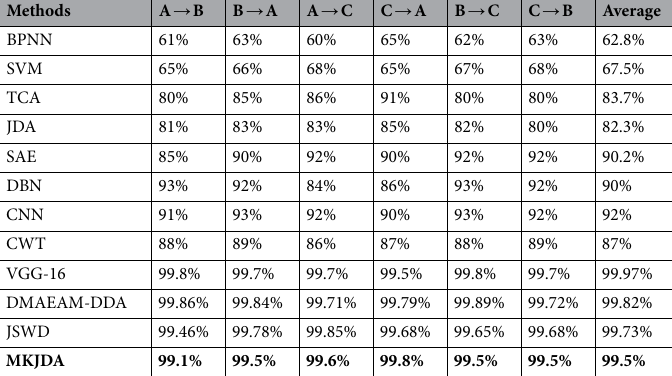
Table 7. The experimental results with three tasks.